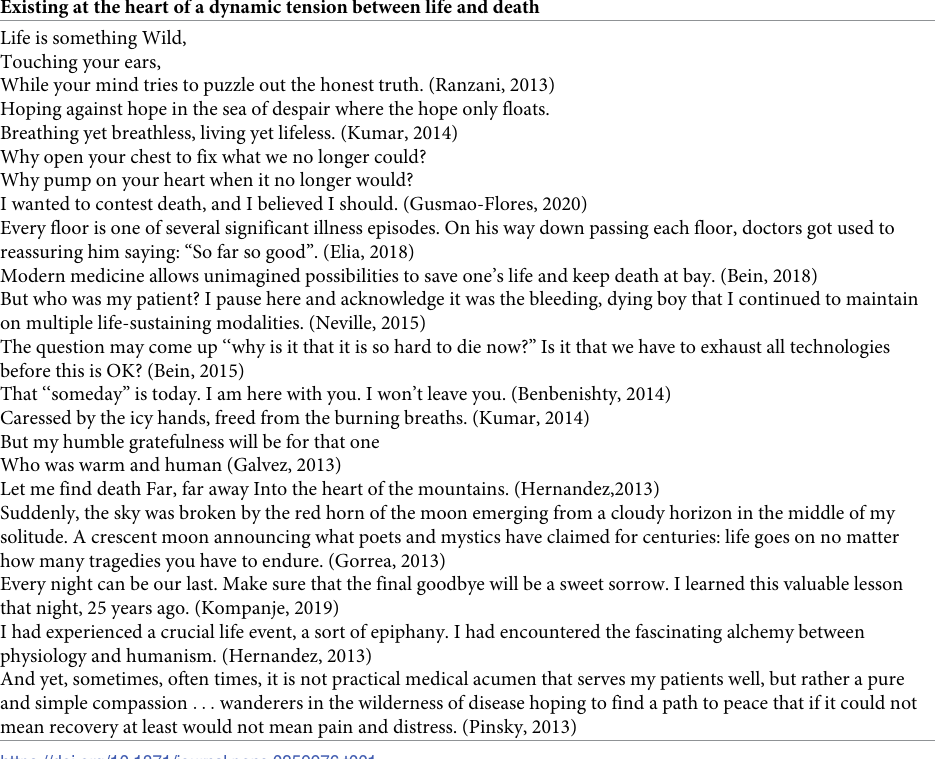
Table 1. Quotation for the main theme. Existing at the heart of a dynamic tension between life and death Life is something Wild, Touching your